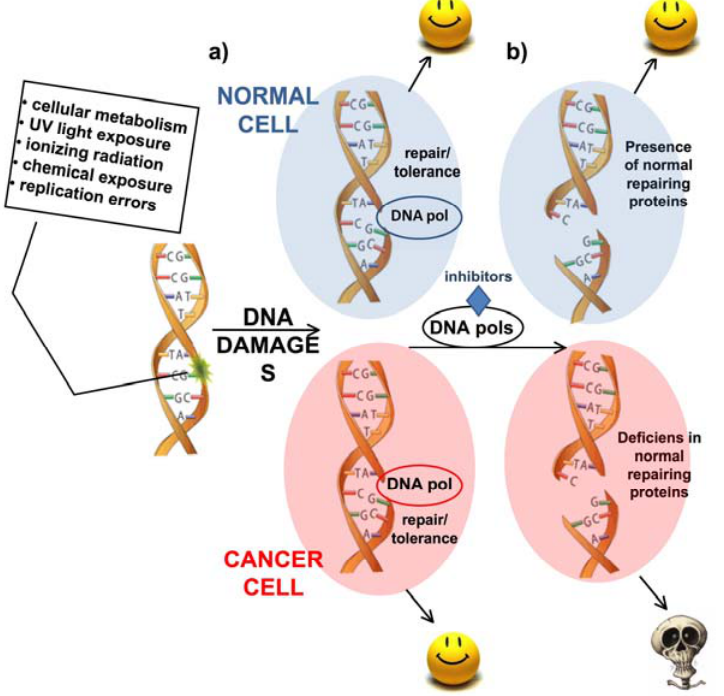
Figure 1. The “synthetic lethality” system represents a new therapeutic approach for selectively killing of cancer cells. Often cancer cells are deficient in specific DNA repair pathways or factors. ( a ) When cells are affected by DNA damages, specific DNA pols are activated that allow both normal or cancer cells to survive. ( b ) In the presence of specific DNA pols inhibitors, cells are not able to repair a DNA damage, which often causes SSBs and DSBs. Normal cells could bypass this problem since they have specific pathways available, instead inhibition of repair DNA pols in cancer cells that are defective in DSBs repair will result in synthetic